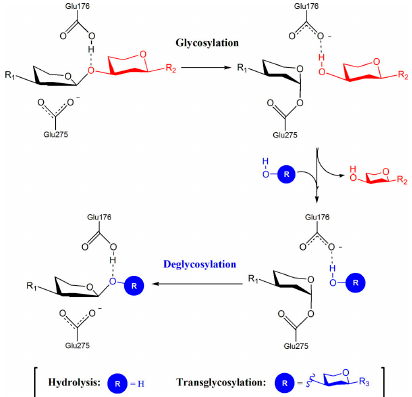
Figure 1. Double-displacement reaction for GHs of family 72. In the first step (glycosylation), a covalent glycosyl–enzyme intermediate (GEI) is formed and the leaving group is released. In the second step (deglycosylation), an acceptor molecule reacts with the GEI generating two different products depending on the nature of the acceptor, either a water molecule (R = H, hydrolysis product) or a sugar acceptor (R = sugar, transglycosylation product). The acid/base residue (E176) and the nucleophile group (E275) are those of Gas2p. Reprinted with permission from [39]. Journal of the American Chemical Society , Copyright 2016, American Chemical